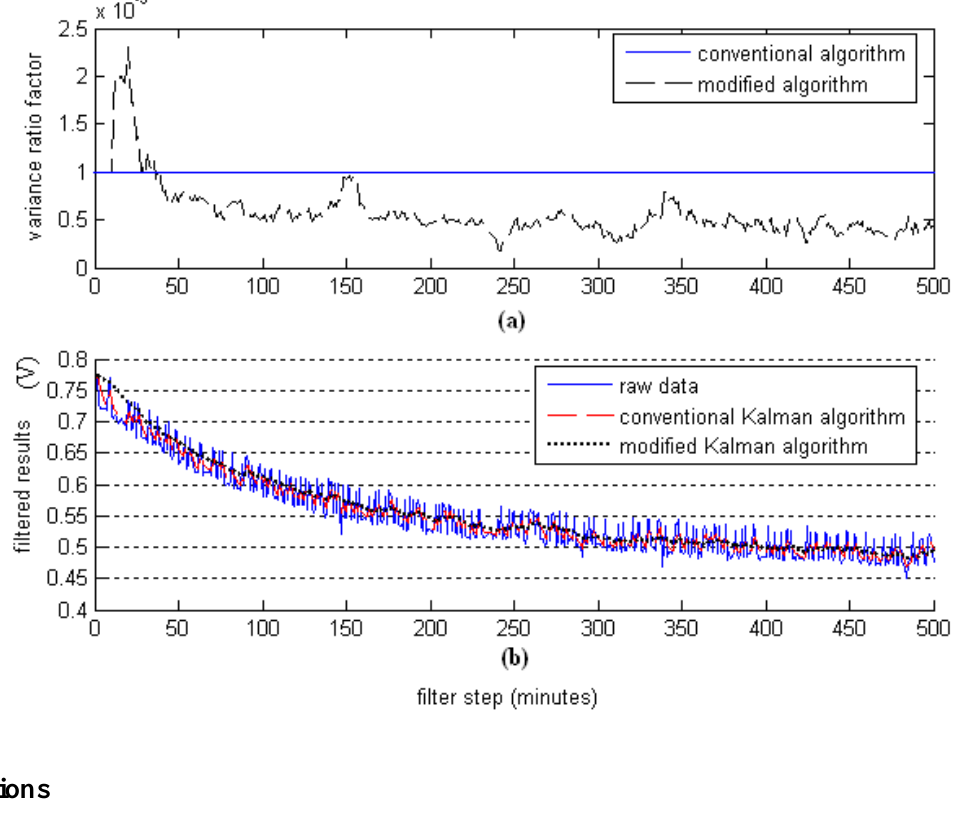
Figure 8. Comparison results between the conventional and the modified Kalman filter algorithm. (a) Estimated value of measurement noise variance; (b) The filtered